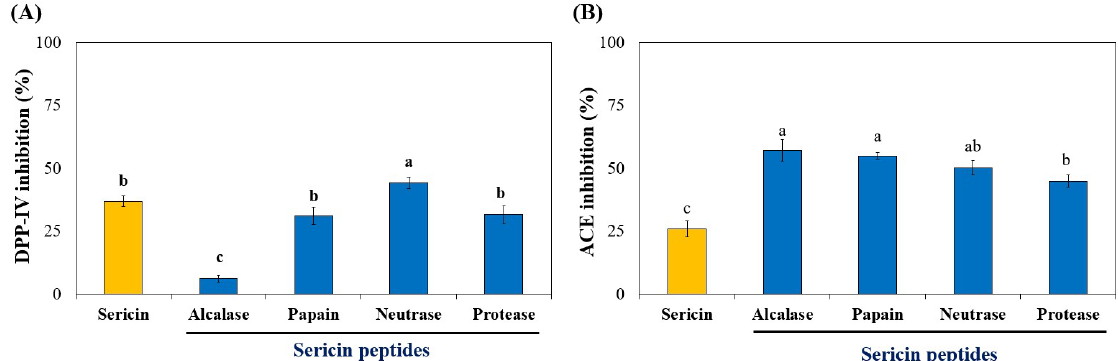
Figure 2. DPP-IV ( A ) and ACE ( B ) inhibitory activities of sericin hydrolysates. The DPP-IV and ACE inhibitory activities were measured in the reaction mixture at final concentrations of 2 mg and 0.2 mg Leu. eq./mL, respectively. Significantly different values ( p < 0.05) are represented by superscript letters (a–c).